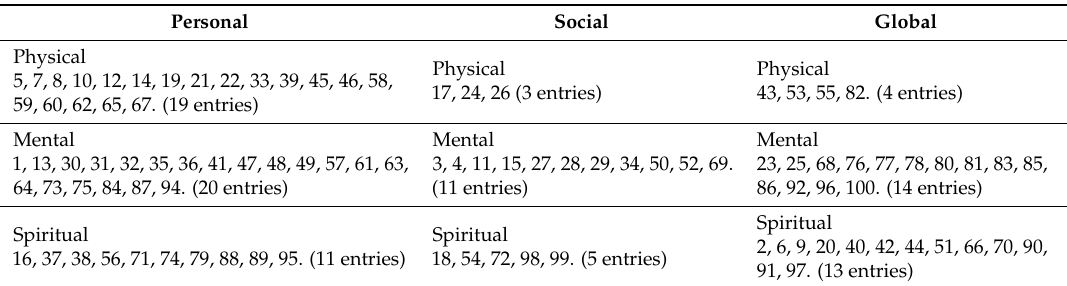
Table 4. Integral consciousness model of physical, mental and spiritual dimensions of personal, social and global coherence. Personal Social